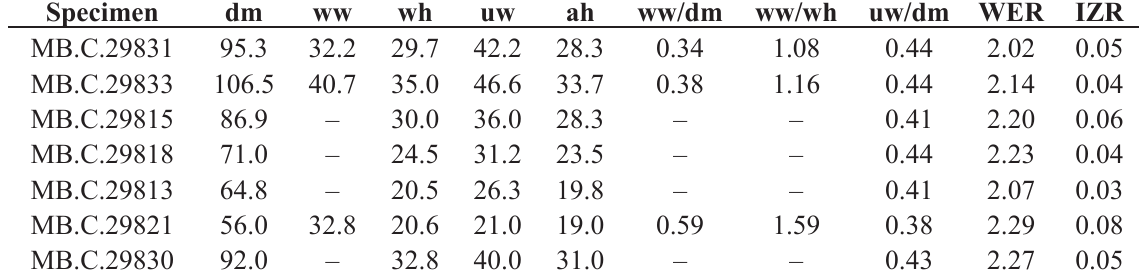
Table 13. Conch dimensions (partly estimated) and ratios of selected specimens of Paratirolites kittli Stoyanow, 1910 from Baghuk Mountain.